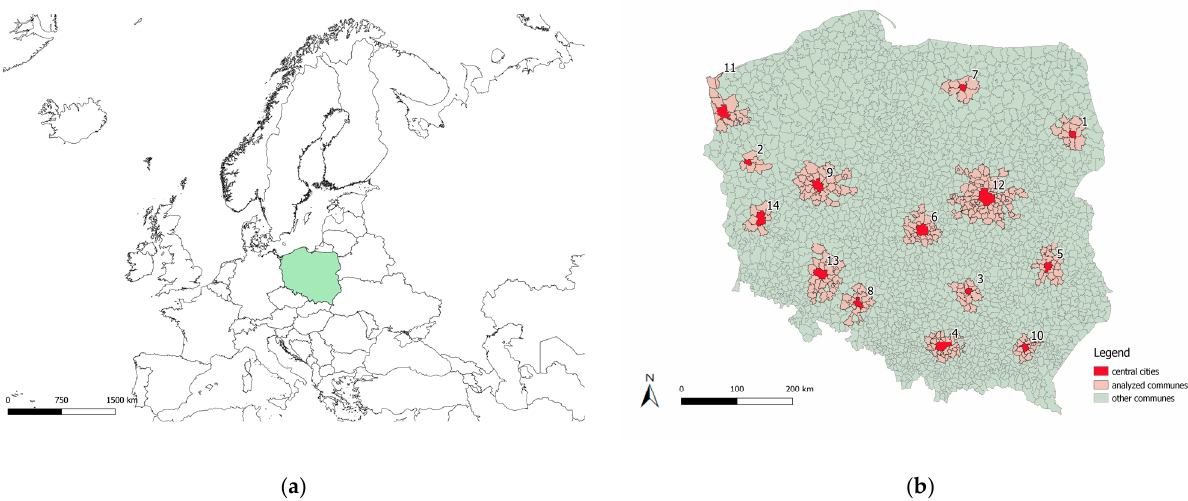
Figure 1. Research area: urban areas in Poland: ( a ) Location of Poland in Europe; ( b ) Analyzed urban areas in Poland: 1. Bia ł ystok, 2. Gorzów, 3. Kielce, 4. Kraków, 5. Lublin, 6. Ł ód ź , 7. Olsztyn, 8. Opole, 9. Pozna ń , 10. Rzeszów, 11. Szczecin, 12. Warszawa, 13. Wroc ł aw, and 14. Zielona Góra